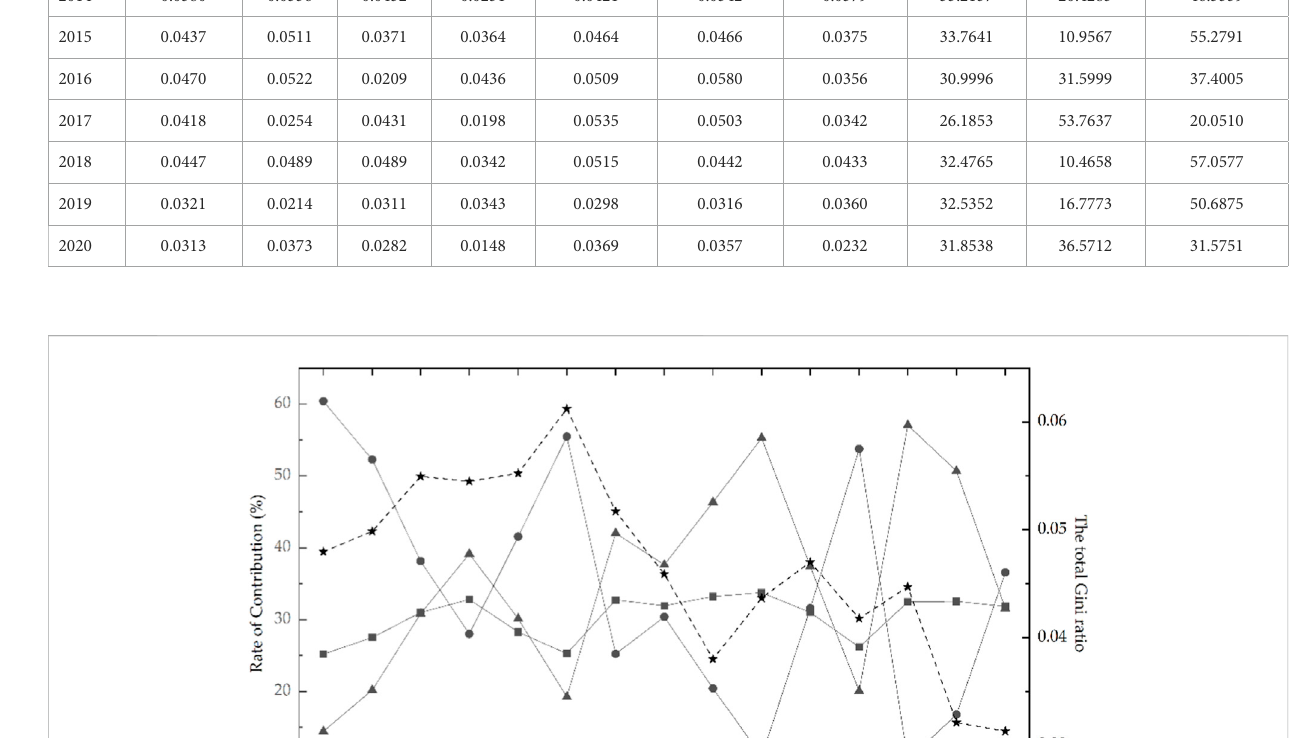
Figure 4 shows that the difference between the eastern and central regions fl uctuates greatly along the mean value. During the sample period, it only decreases by 0.0001, and the decrease is minimal, but the fl